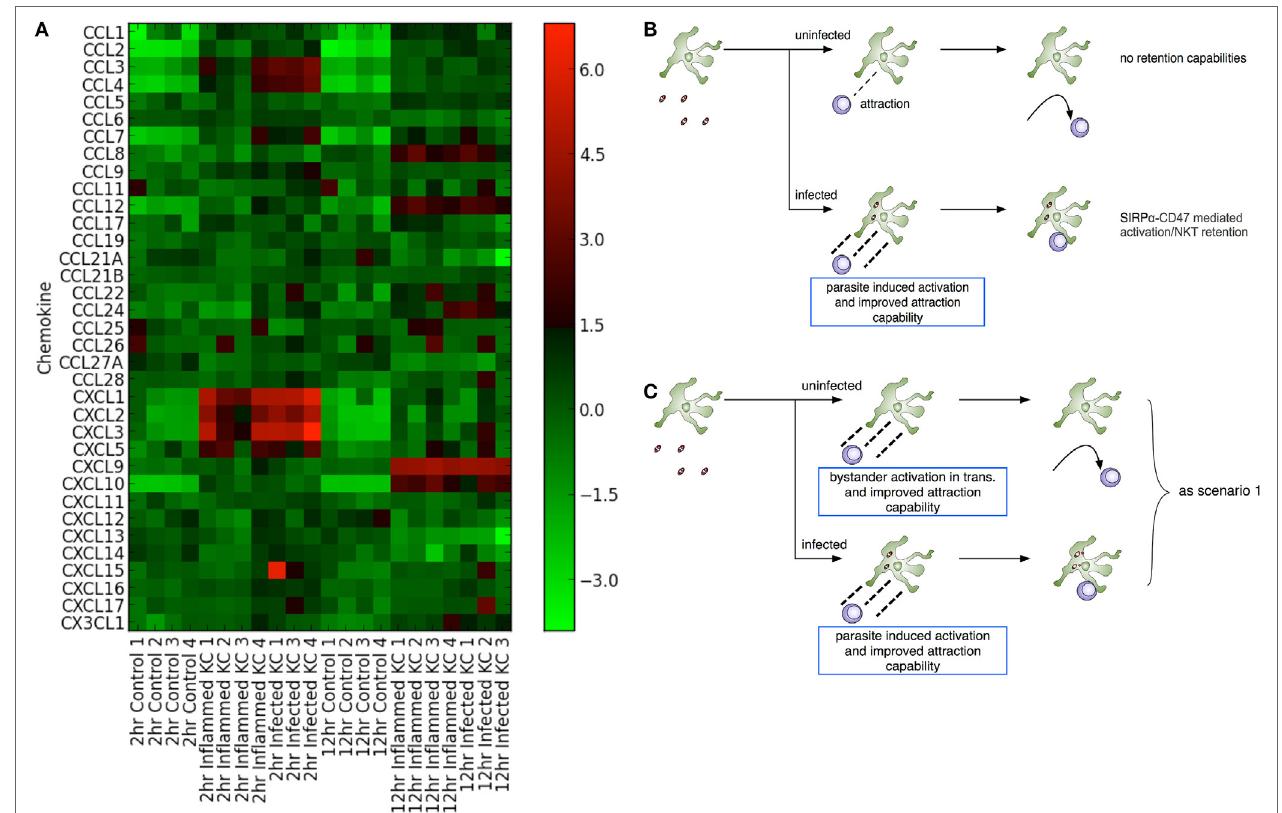
FigUre 1 | Leishmania donovani infection induces transactivation of Kupffer cells (KCs) for chemokine production. (a) Heat map showing chemokine mRNA abundance in flow sorted KCs from naïve mice (control) and from KCs isolated from infected mice and separated into those containing parasites (“infected”) and those that do not contain parasites (“inflamed”). KC isolation was performed at 2 and 12 h postinfection, with matched controls. Lanes numbered 1–4 indicates separate sorts. The gating strategy for separating “infected” from “inflamed” KCs is provided in Figure 3 of Ref. (31). (B,c) Two modeling scenarios were generated. In scenario 1 (B) , only infected KCs produce sufficient chemokine to attract and retain natural killer T (NKT) cells. In scenario 2 (c) , both infected and inflamed KCs produce chemokines to attract NKT cells, although only infected KCs have the ability to retain these through cognate